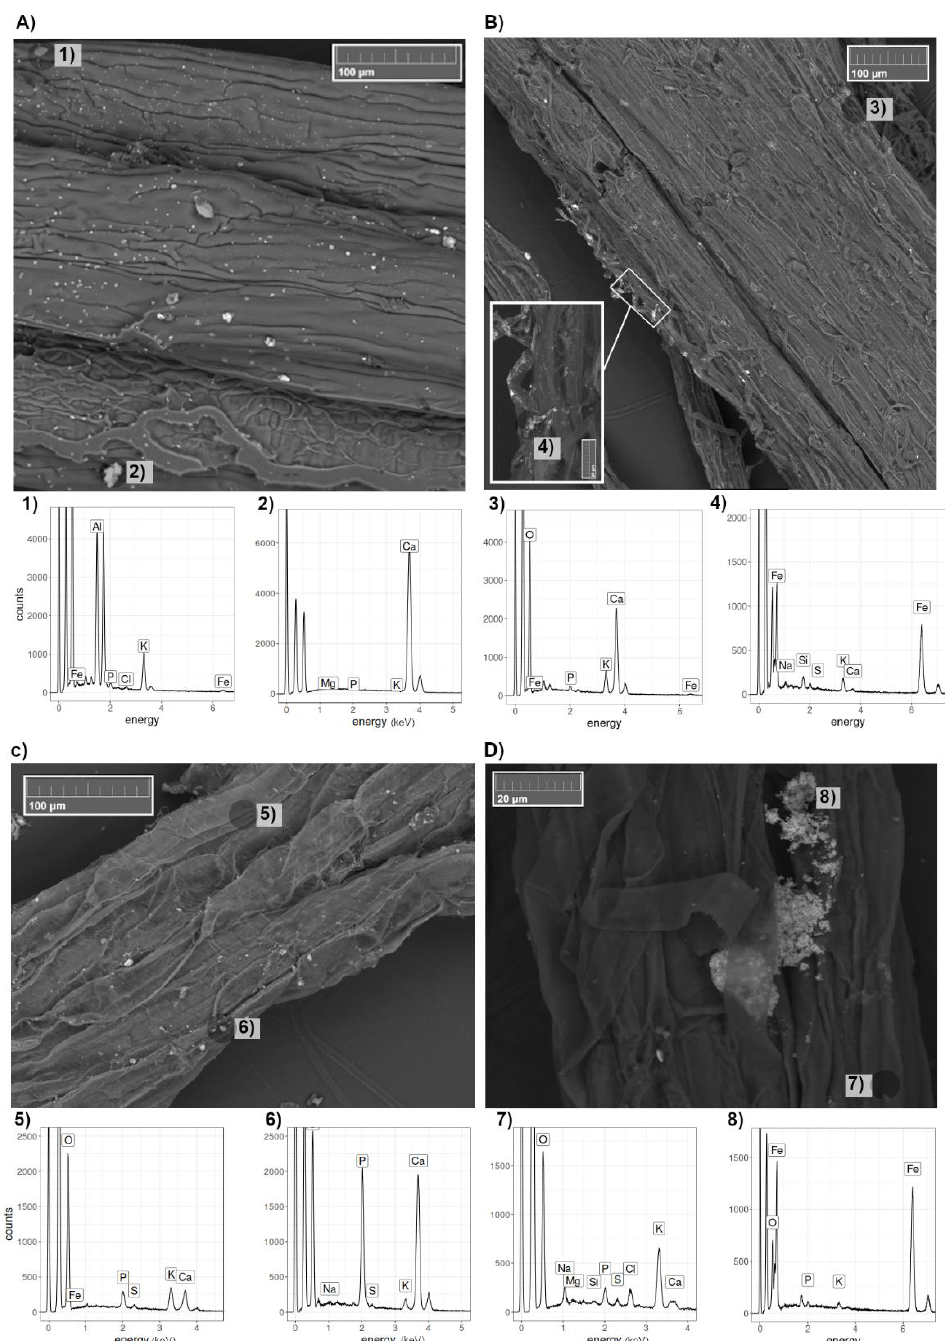
Figure 3. Roots of A. capillaris (above, ( A , B )) and F. rubra (below, ( C , D )) treated with (T100) / without (T0) nZVI (right and left, respectively) under a scanning electron microscope (SEM) with their corresponding energy dispersive X-ray spectrometer (EDS) spectra ( 1 – 8 ).